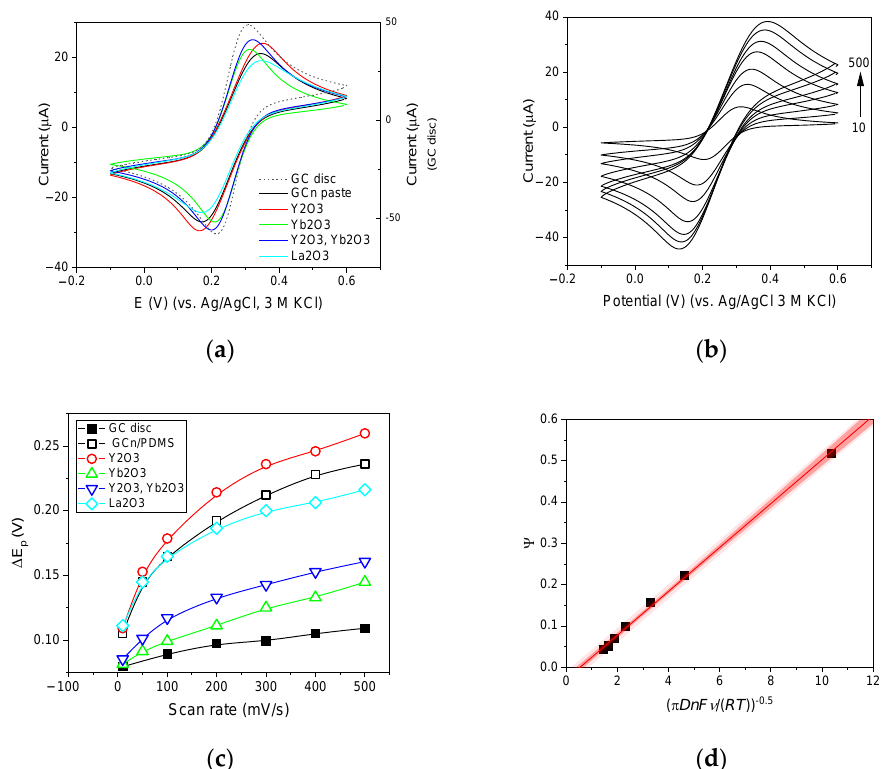
Figure 4. ( a ) Cyclic voltammograms of 0.005 M K 3 [Fe(CN) 6 ] recorded in 1 M Na 2 SO 4 by a GC disc electrode, an unmodified paste electrode GC n /PDMS, and GC n /PDMS paste electrodes modified with oxide addition at a scan rate of v = 100 mV/s. ( b ) Cyclic voltammograms of 0.5 mM 0.005 M K 3 [Fe(CN) 6 ] recorded in 1 M Na 2 SO 4 using a GC n / PDMS paste electrode at scan rates of 10, 50, 100, 200, 300, 400 and 500 mV/s. ( c ) The peak-to-peak separation ∆ E p measured for K 3 [Fe(CN) 6 ] voltammograms recorded by the GC disc electrode, the unmodified GC n /PDMS paste electrode and GC n /PDMS paste electrodes modified by oxide addition. ( d ) Plot of Ψ vs. [ π DnFv/RT] − 0.5 was prepared using data provided in Figure 4b K 3 [Fe(CN) 6 Table 1. Summary of cyclic voltammetric data for disc and paste electrodes. Cyclic voltammograms were recorded in 1M Na 2 SO 4 containing 0.005 M Fe(CN) 63- at a scan rate of 100 mV/s.